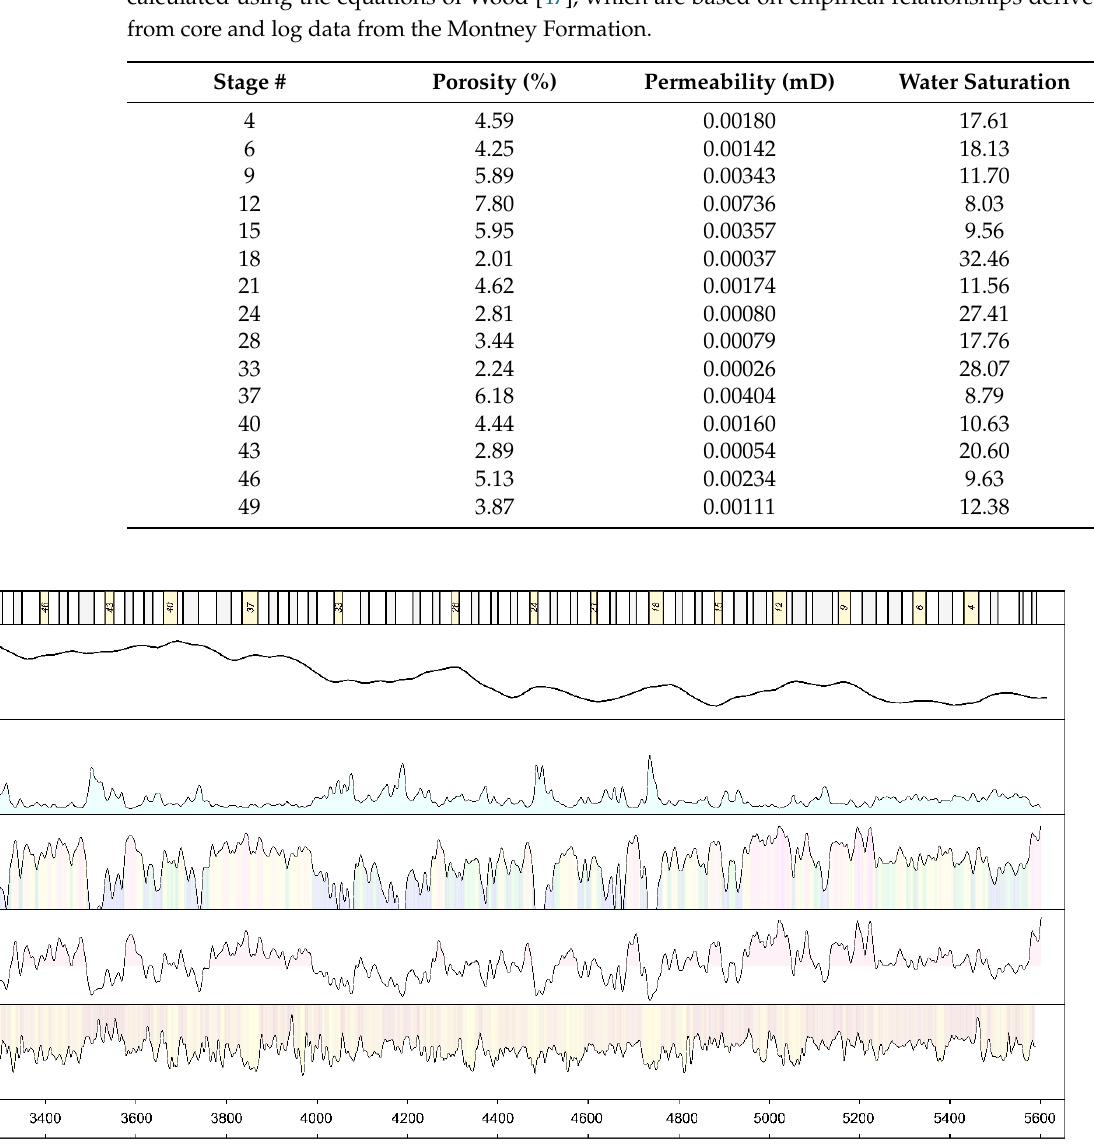
Figure 11. Location of the 15 selected stages along the horizontal well. Well trajectory, permeability/porosity/water saturation derived from the Part 1 study, and the gamma ray log are also provided.